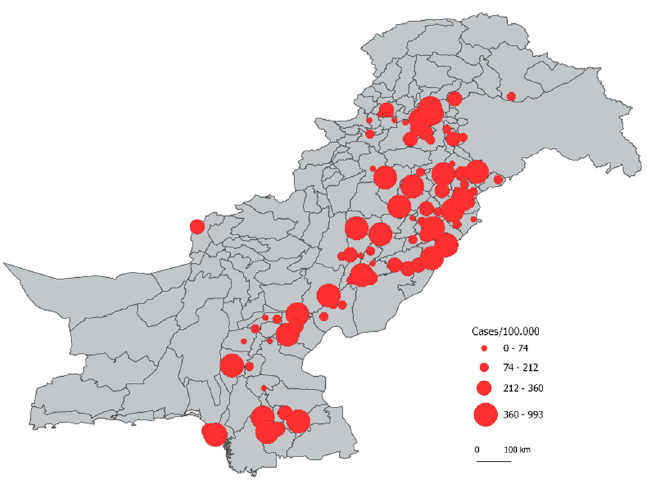
Figure 1. Proportion of TB bacteriologically positive people (out of all tested) by cluster in Pakistan in 2010–2011 prevalence survey [21].